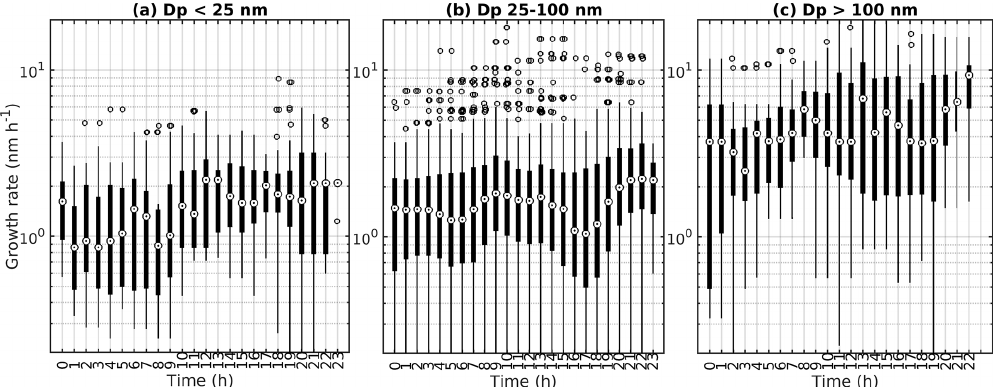
Figure 8. Diurnal cycles of growth rates divided by the diameter (Dp) of growing particles. The circles are the median concentrations, black boxes mark the 25th and 75th percentiles, and the rest of the points are outside this range.